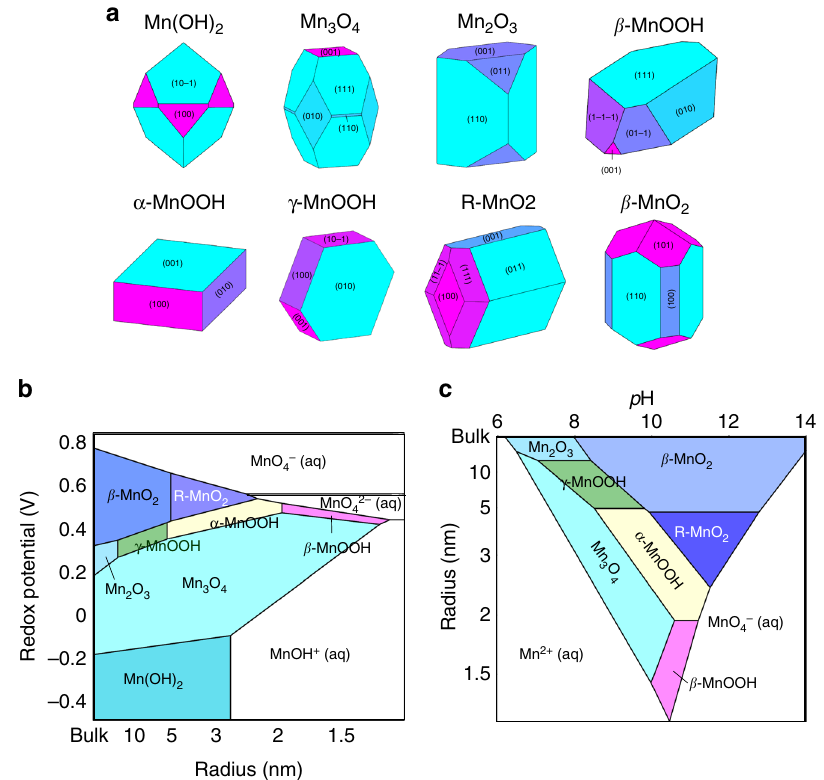
Fig. 2 Surface energy contributions to Mn – H 2 O phase equilibria at the nanoscale. a DFT-computed Wulff constructions of the equilibrium particle morphologies of size-stabilizable manganese oxide phases. Detailed surface energy data can be found in Supplementary Note 3, and Supplementary Tables 2-11, and Supplementary Figs. 5-14. Wulff constructions are color-coded by the relative surface energies of each facet; blue indicates lower relative surface energy, magenta indicates higher. b Size-dependent Pourbaix diagrams at [Mn] = 10 − 2 M and 25 °C, with varying redox potential at fi xed pH = 11, and with c varying pH, at fi xed redox potential E = 0.5